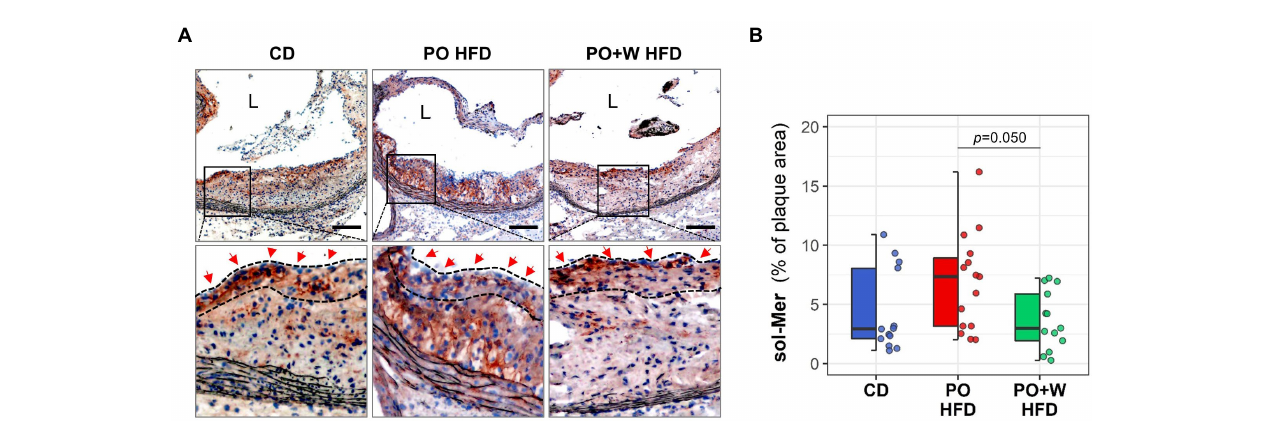
FIGURE 5 Inclusion of walnuts attenuates defective efferocytosis in atherosclerotic lesions. (A) Representative images [magnification × 100; scale bars, 100 μ m; and high-magnification fields (squared areas)] and (B) Quantitative analysis of histochemical detection of sol-Mer in aortic sections. Dashed lines and red arrows in high-magnification fields define fibrous cap regions. Dot and box plots show individual values and depict the median (horizontal bar), interquartile range (IQR, hinges) and 1.5 × IQR (whiskers). Results in bar plots are presented as individual data points and mean ± SEM of the intervention groups. CD, control diet ( n = 14); PO HFD, palm oil-based high-fat diet ( n = 15); PO + W HFD, palm oil + walnuts high-fat diet (isocaloric inclusion of 3% of walnuts at expense of palm oil, n = 14). p values obtained by one-way ANOVA (after log-transformation) with Bonferroni post hoc correction. L,